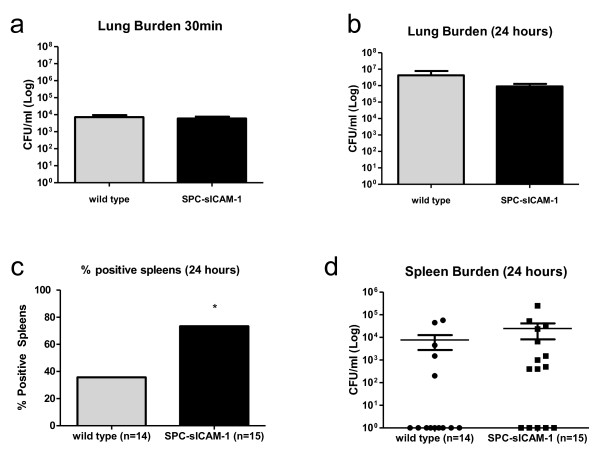
Increased systemic dissemination, but similar lung burden, occurs 24 hours after K. pneumoniae infection. SPC-sICAM-1 mice and wild-type mice were inoculated intranasally with 2500 CFU of K. pneumoniae. After 30 minutes (a) and 24 hours (b), the animals were euthanized, and K. pneumoniae CFU were determined in lung homogenates. The percentage of positive spleen cultures and CFU were determined at 24 hours(c, d). Data are expressed as CFU per milliliter (mean ± SEM; n = 3 at 30 minutes; n = 14 for wild type and n = 15 for SPC-sICAM-1 at 24 hours; * P < 0.05 compared with wild-type).